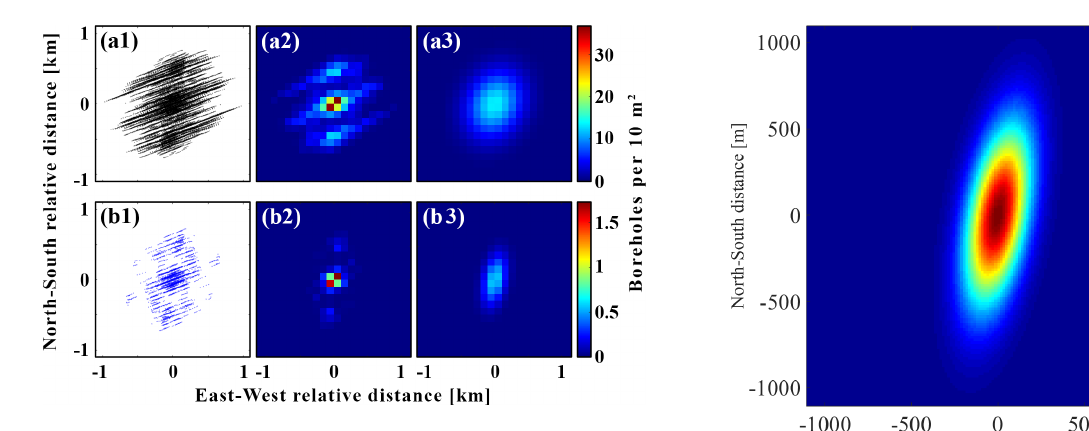
Figure 8. (a1) Relative positions of all 718341 possible pairs of boreholes in selected time windows. (a2) Gridded density map of the relative positions in panel (a1) . (a3) Density map derived from the best bivariate Gaussian distribution fit to the relative positions in panel (a1) . (b1) Relative positions of all 9514 pairs of boreholes identified as hydraulically connected in selected time windows. (b2) Gridded density map of the relative positions on panel (b1) . (b3) Density map derived from the best bivariate Gaussian distribu- tion fit to the relative positions in panel (a1) .